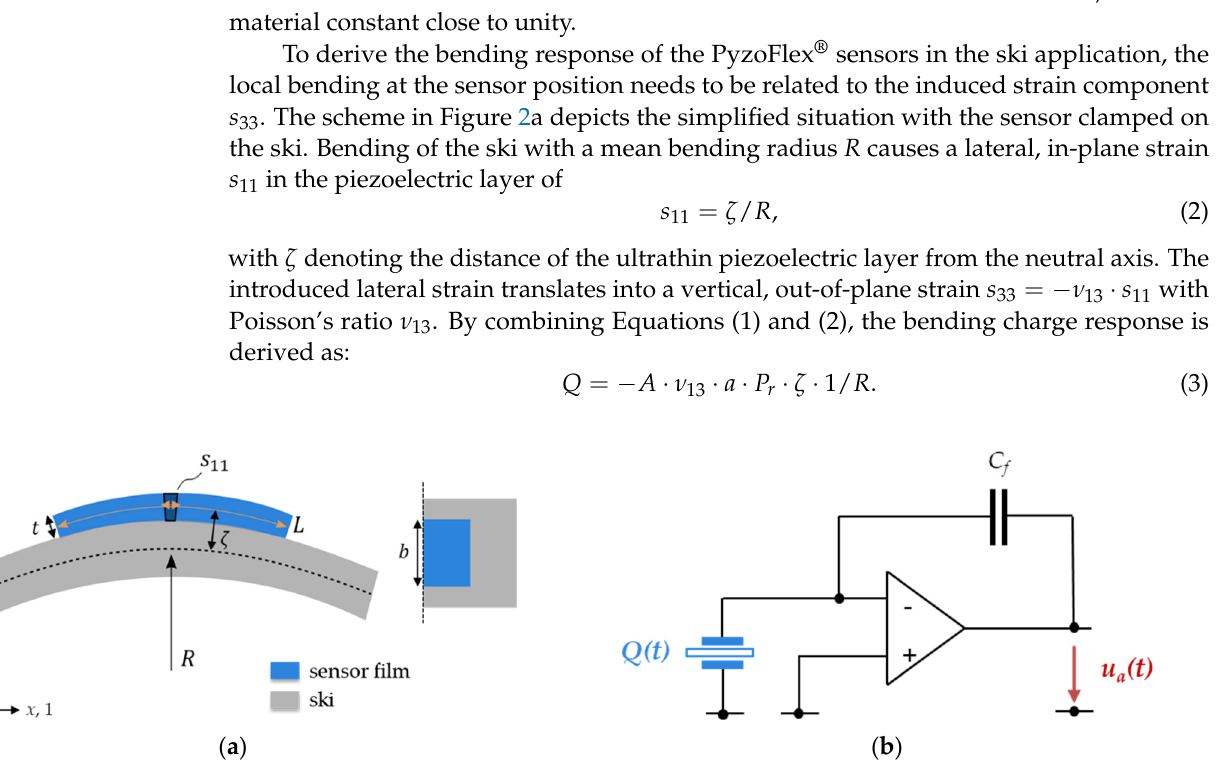
Figure 2. ( a ) The bending scheme of a PyzoFlex ® sensor film mounted on top of the ski at the bending radius R = 1/w′′(x) (see main text) in cross-section view (left) and top view (right). The bending of the sensor causes a lateral, in-plane strain s 11 in the piezoelectric layer. The sensor element has length L, width b and thickness t, and the sensitive, piezoelectric layer is located at a radial distance ζ off the neutral axis. ( b ) The sensor generates a charge Q ( t ) , which is converted into a proportional output voltage u a ( t ) . C f corresponds to the capacitance in the feedback